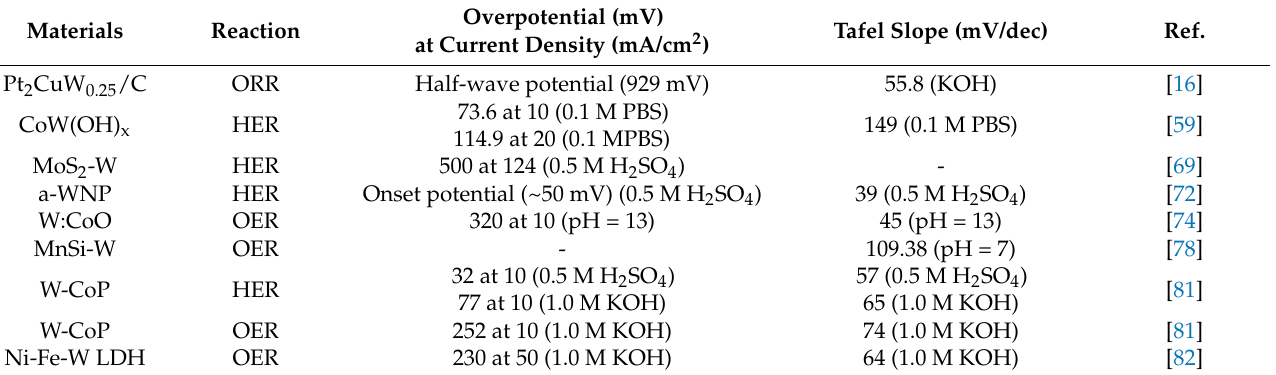
Table 3. Electrochemical parameters of tungsten metal nanocatalysts currently